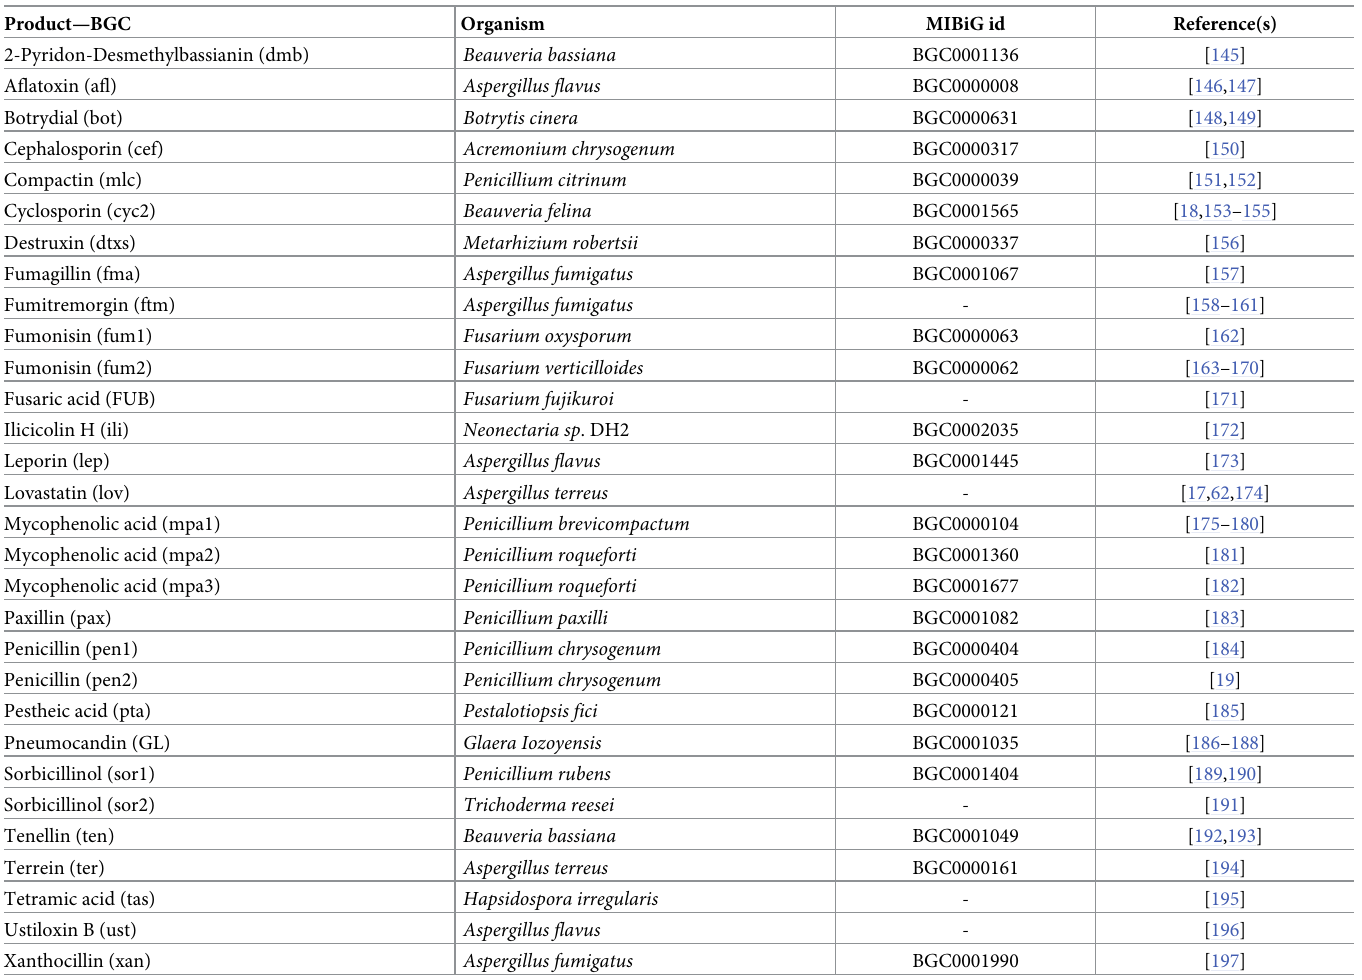
Table 2. Empirically characterized biosynthetic gene clusters used as positive